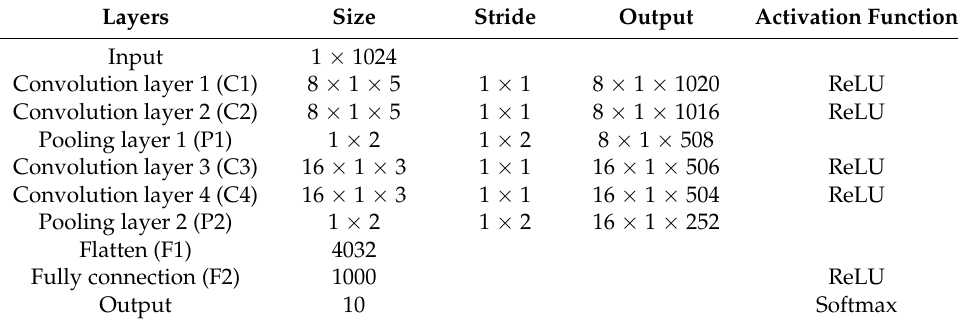
Table 1. Parameters of deep convolution neural network.